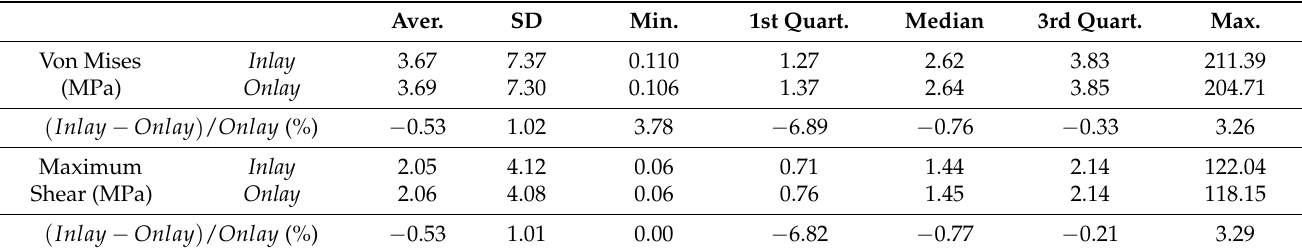
Figure 8. Smoothed stress distributions for the “bed” adhesive resin cement. ( a ) Inlay restoration (left side) and onlay restoration (right side). ( b ) Box plot of the distributions for the two “bed” geometries. Table 11. Statistical description of the stress distributions for the “bed” geometry at the adhesive resin cement. Aver. Min. 1st